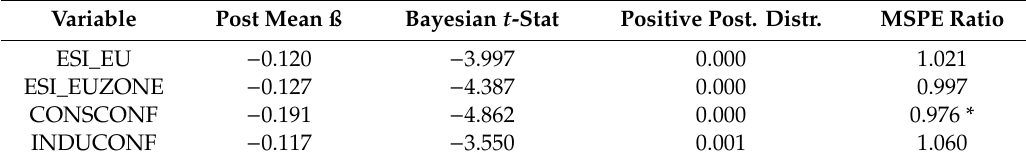
Table 4. Set of estimations run using the EU sentiment indices in order to predict the U.S. market.